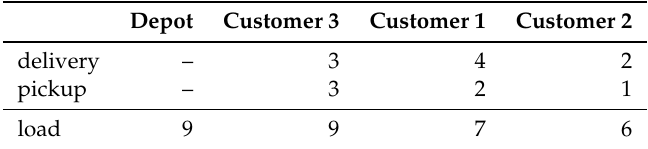
Table 4. Vehicle load of the tentative route 0 − 3 − 1 − 2 −